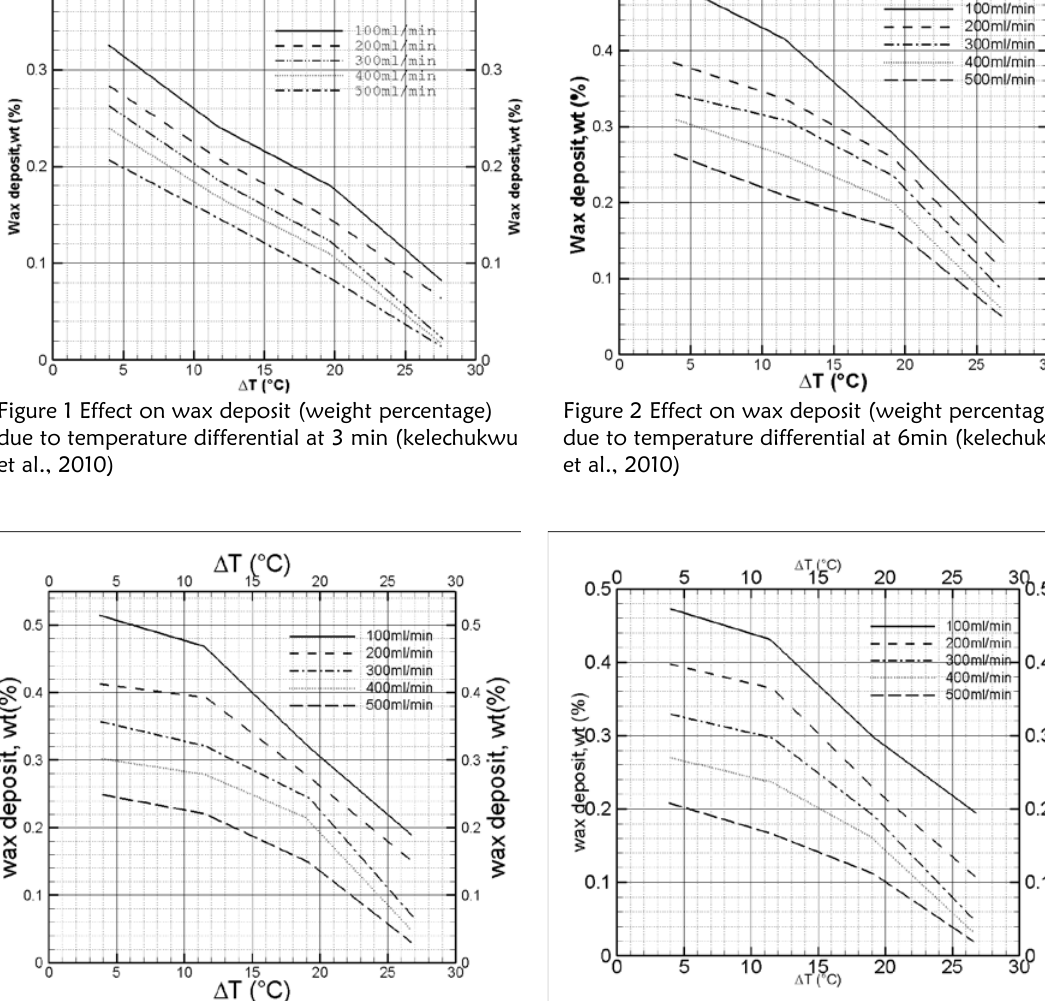
Figure 4 Effect on wax deposit (weight percentage) due to temperature differential at 12 min (kelechukwu et al.,